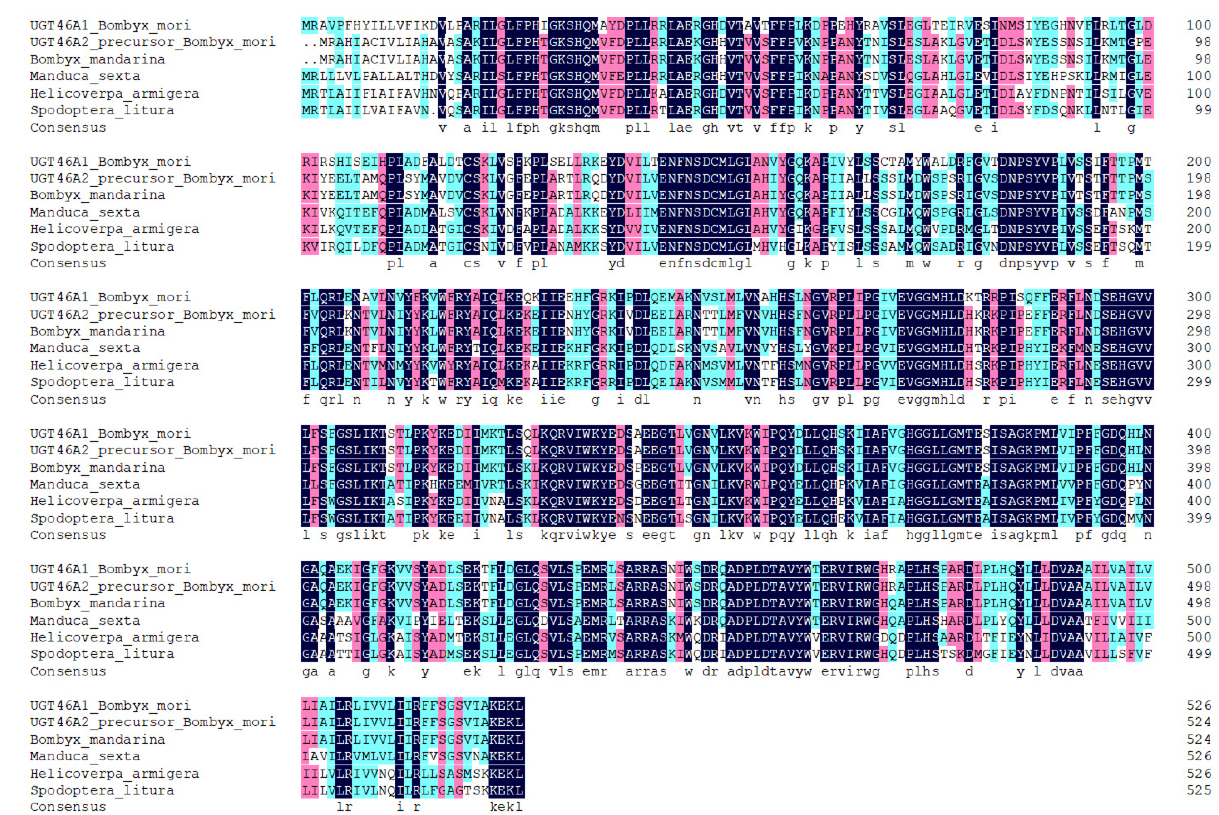
Processes 2021 , 9 , x FOR PEER REVIEW 7 of 14 Figure 2. Alignment of the amino acid sequence similarity of BmUGT46A1 (NP_001243982), BmUGT46A2 precursor (NP_001243972), and BmUGT46A1 homologous protein in Bombyx mandarina (XP_028030281), Manduca sexta (KAG6449394), Helicoverpa armigera (XP_021186279), and Spodoptera litura (XP_022814630).